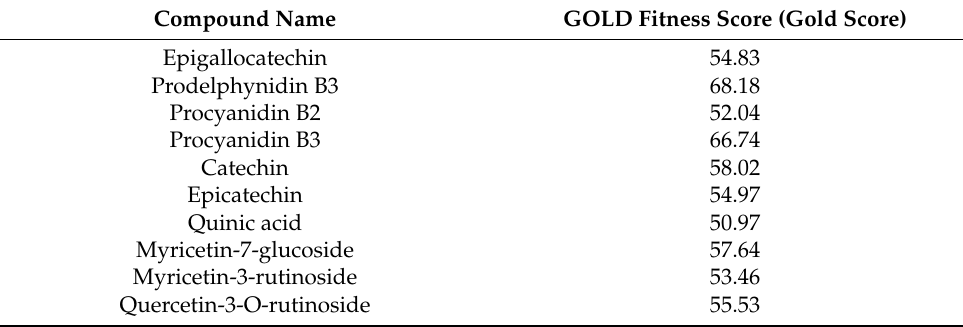
Table 1. Docking scores expressed as Gold Fitness